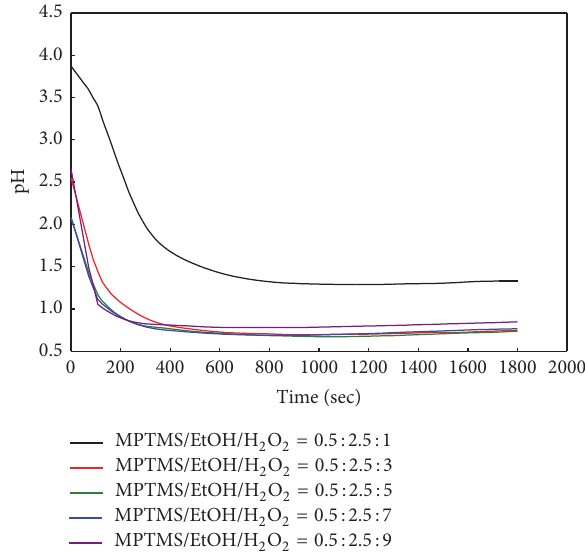
Figure 4: The reaction time dependence of pH value for the sulfonated MPTMS